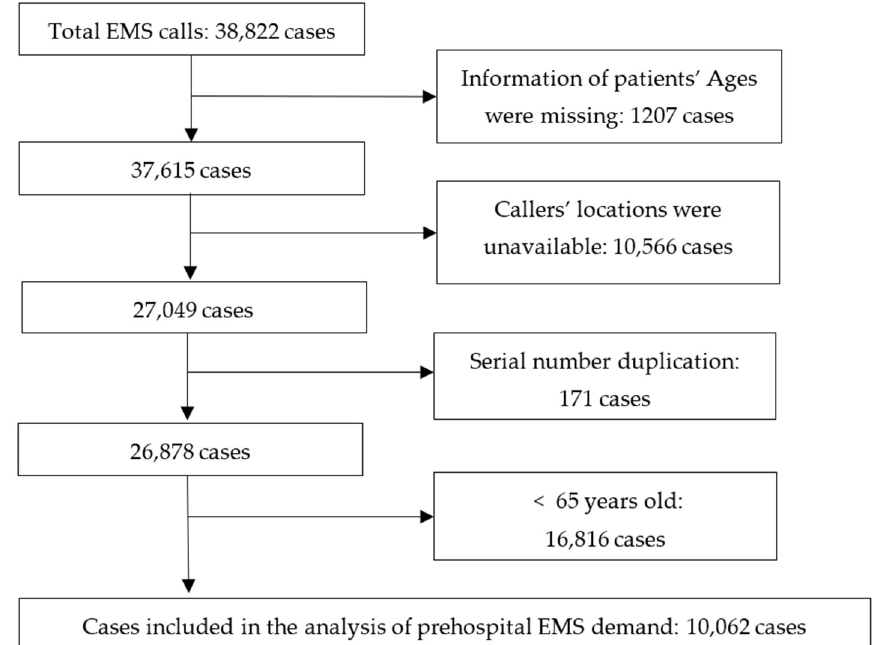
Figure 3. Summary of the schematic of the data management.